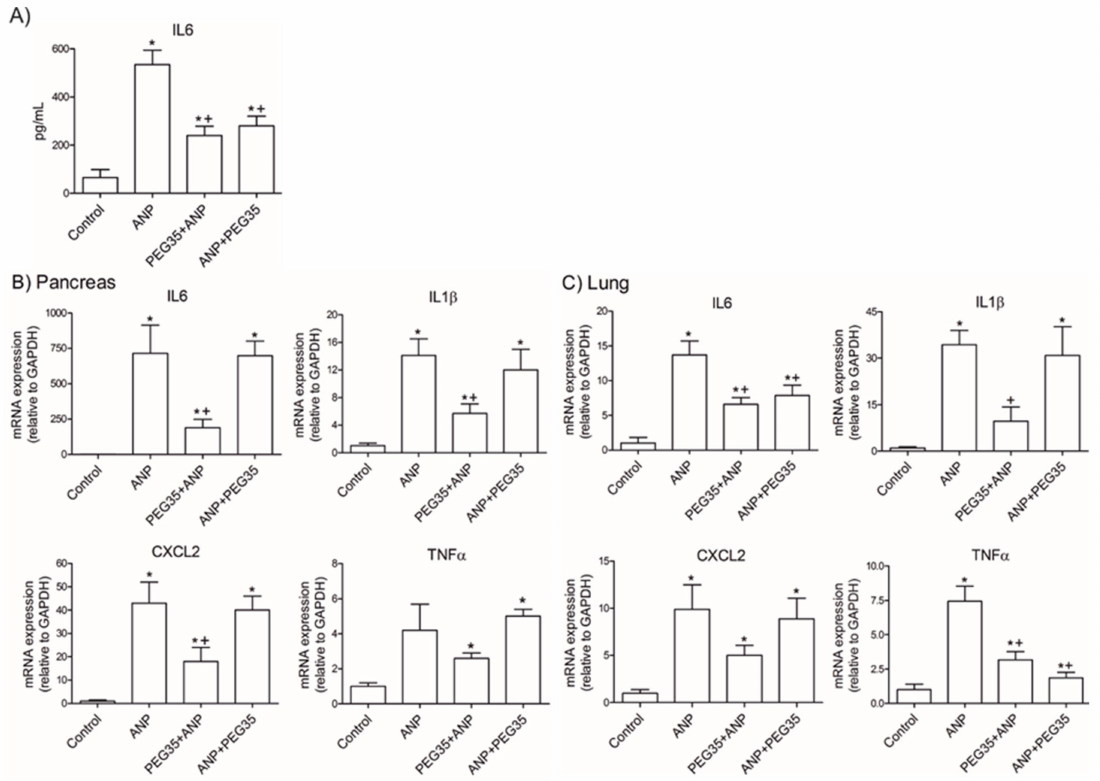
Figure 3. Role of PEG35 on the modulation of pro-inflammatory cytokines and chemokines expression in sodium taurocholate acute necrotizing pancreatitis and associated acute lung injury. ( A ) IL6 expression levels in plasma. ( B ) Pancreatic tissue gene expression of IL6, IL1 β , CXCL2 and TNF α by real-time qRT-PCR. ( C ) Lung tissue gene expression of IL6, IL1 β , CXCL2 and TNF α by real-time qRT-PCR. In all cases, mRNA induction levels were normalized to GAPDH mRNA expression. Bars represent mean values of each group ± SEM. * p < 0.05 versus Control, + p < 0.05 versus ANP. ANP, Acute Necrotizing Pancreatitis. PEG35, Polyethylene glycol 35. Each determination was carried out in